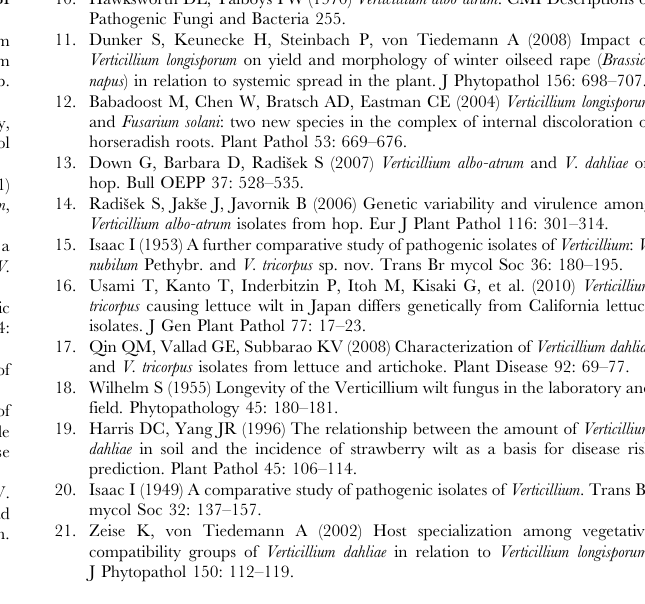
Table S4 Numbers of substitutions at primer sites among a representative sample of Verticillium strains and a Gibellulopsis nigrescens outgroup [ 4,47 ] . Substitu- tion numbers marked by an asterisk are inferred from DNA sequence alignments (Alignments S1, S2, S3, S4, S5), see Table S2 for accession numbers. The remaining substitution numbers are derived from single-locus phylogenetic trees in Inderbitzin et al.